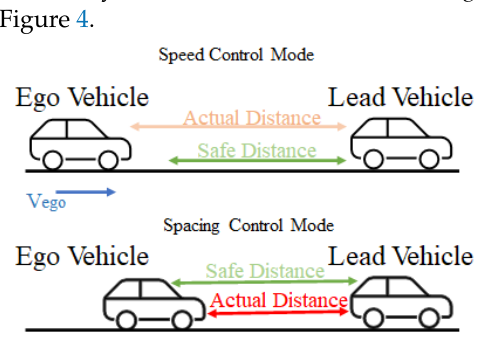
Figure 4. Adaptive cruise control-model operational modes.